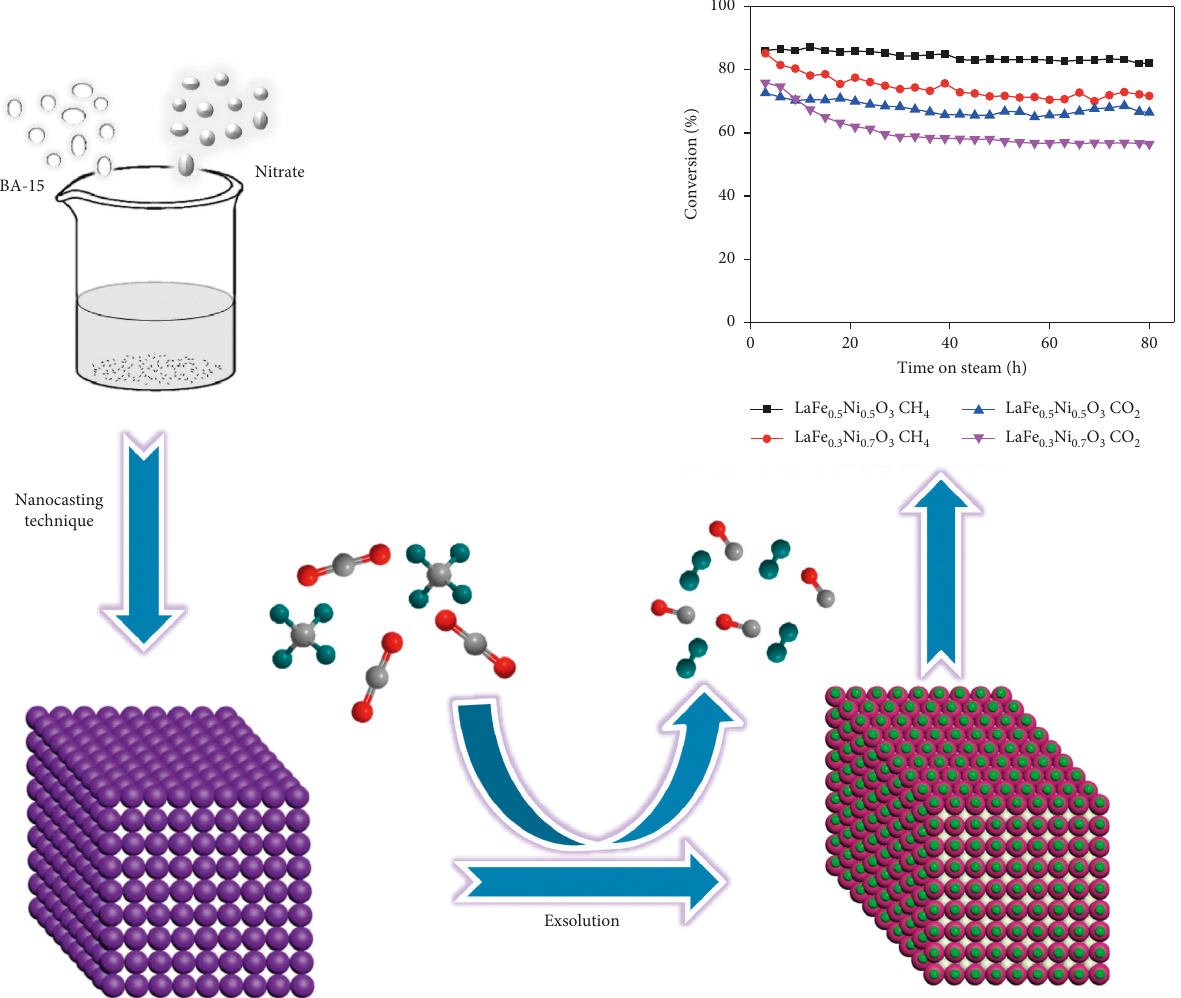
Scheme 1: Schematic diagram of the catalyst preparation.